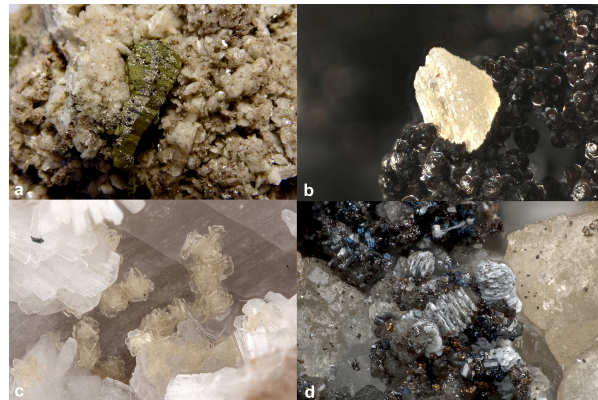
Figure 1. Alicewilsonite-(YCe) from Mont Saint-Hilaire, Quebec, Canada: (a) green-yellow spindle-shaped prismatic crystal 2cm in length, partially encrusted by pyrite, on albite. Alicewilsonite- (YCe) composes the outer part of the crystal, while the inner part is made of donnayite-(Y) and gaidonnayite. Specimen CMNMC 53660 (the holotype); (b) yellow saucer-shaped crystal 0.5mm in size with brown stilpnomelane. Specimen CMNMC 89598; (c) yel- low transparent platy crystals. FOV 4mm. Specimen CMNMC 89605; (d) pale-grey stacked saucer-shaped crystals. FOV 1.5mm. Specimen CMNMC 90249. Canadian Museum of Nature collec- tion. (b–d) Photos: François